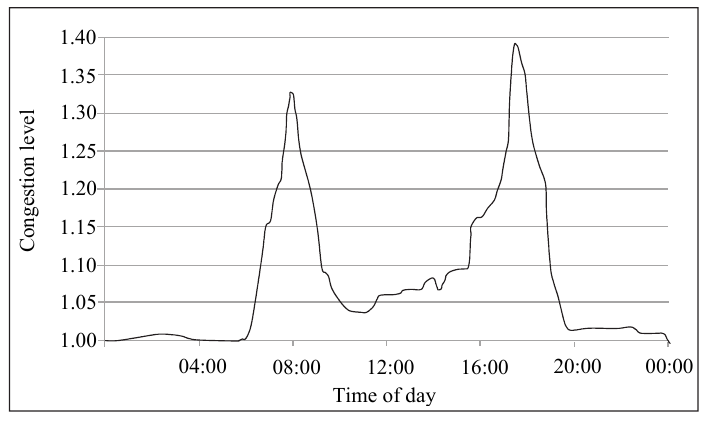
Fig. 1. Variation in Congestion by